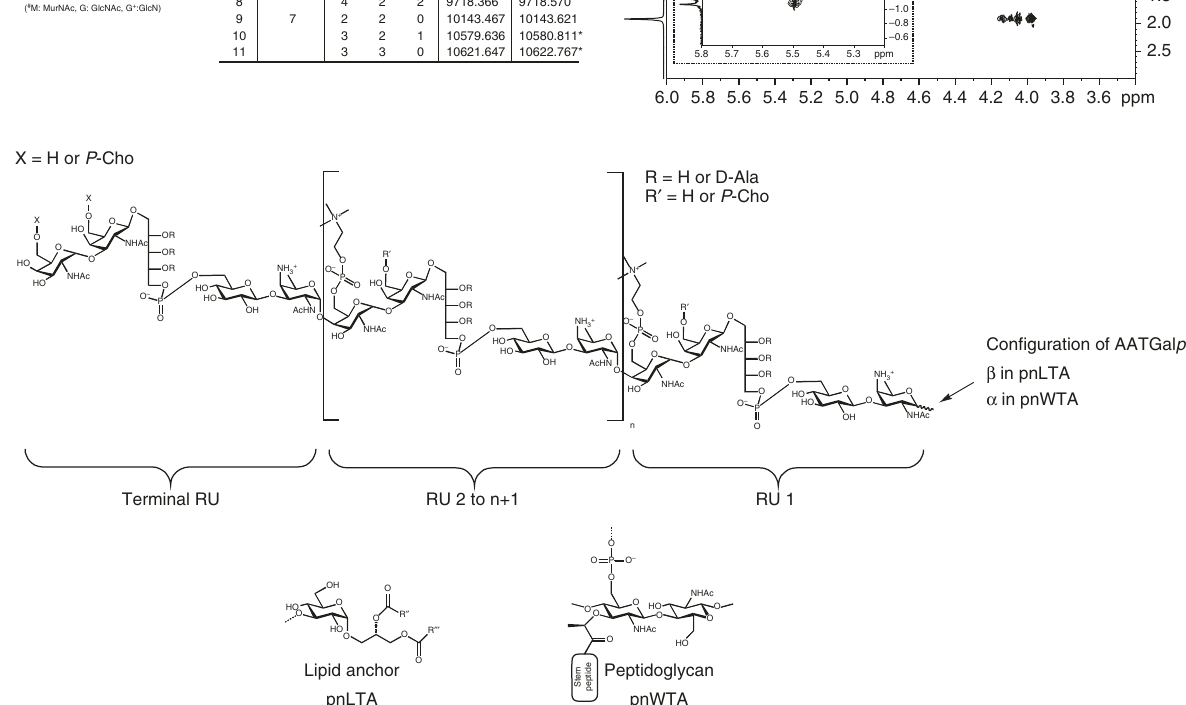
Fig. 1 Structural analysis of pnWTA bound to small PGN saccharides from S. pneumoniae D39 Δ cps Δ lgt and chemical structures of pnTAs. a Section of the charge deconvoluted ESI-FT-ICR-MS spectrum (acquired in negative-ion mode). Signals for molecules 1 – 11 represent pnWTA with 5 – 7 RUs bound to small PGN-derived saccharides; observed and calculated masses are given. *only second isotopic peak was observable. b Section ( δ P 5.0-( − 5.0)) of the 31 P NMR including assignment of signals. Magni fi cation shows 31 P NMR signals that are not observable in pnLTA preparations 7 (compare Fig. 2). c Section ( δ H 6.00-3.40; δ P 3-( − 2)) of the respective 1 H, 31 P HMQC NMR spectrum. The important region for the linkage phosphate is magni fi ed. Cross correlation of the phosphates between δ P − 1.0 and − 1.3 into the broadened signal in 1 H NMR ( δ H 5.51 – 5.47) could be assigned to the anomeric proton of α -AATGal p , proving the stereochemistry of this bridging phosphate is an α -1-linked atom. d Chemical structures of pnTAs. RUs of both TAs contain the same pseudo-pentasaccharide building blocks, whereby the terminal RU can occur with or without 6- O - P -Cho-substitution on both Gal p NAc. A few mono- P -Cho-substituted TAs lack the P -Cho at β -Gal p NAc (R ′ ). In pnLTA, the fi rst RU is β -1-linked to the lipid anchor ( α -D-Glc p -(1 → 3)-DAG); consistent with the α -con fi guration of the respective linkage of pnWTA to PGN. All other RUs are α -glycosidically linked to the previous one. Hydroxyl groups of ribitol can be substituted by D-alanine (D-Ala; R). n number of RU; R ′′ and R ′′′ , alkyl or alkenyl residues of fatty acid chains in lipid anchor (summarized in ref. 8 )